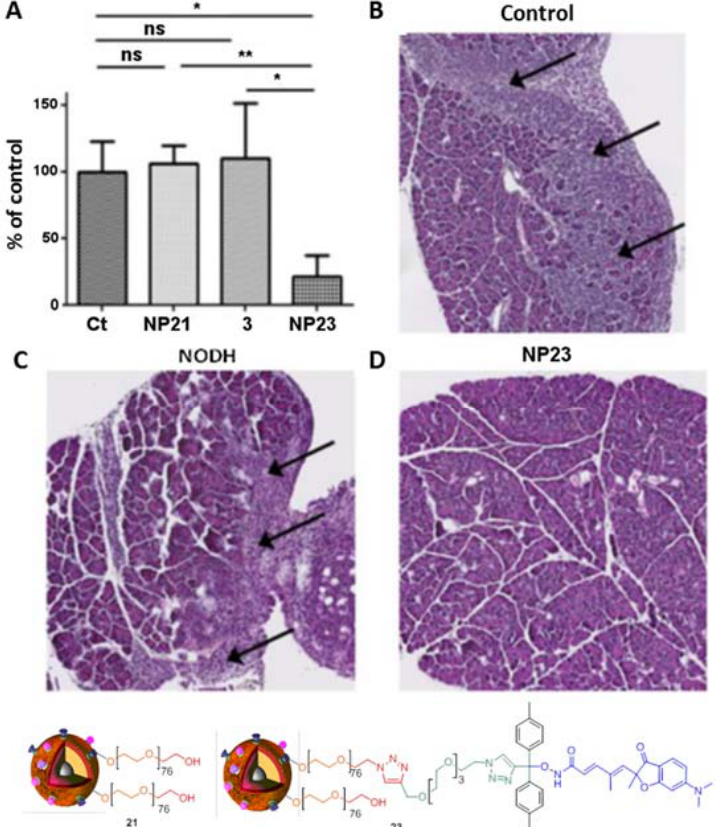
Figure 6. Anti-tumor activity of NPs 23 . Four groups (G1-G4) of C57Bl/6 mice bearing orthotopic AK7 tumor received intraperitoneal injection of decitabine (4 µ g/g) at days 7 and 9, followed by injection IV of NPs 21 (hydroxyl NPs 80 µ g/g, G2), of NODH (0.25 µ g/g, G3), or NPs 23 (0.25 µ g/g compound, 16 µ g/g polymer, G4). G1 group received no treatment. ( A ) Graphic representation of tumor weight at the end of the protocol. ( B – D ) Histological pictures after HES staining of pancreas from control group G1 ( B ), group G3 treated with NODH ( C ), or group G4 treated with NPs 23 ( D ). Arrows indicate infiltration of tumor cells in pancreatic tissue. Ns, none significant. * p < 0.05. ** p < 0.01. The anti-tumor effect obtained in the group treated with NPs 23 was associated with an increase of histone H3 acetylation in cancer cells (brown staining of cell nuclei) (Figure 7A) whereas no change in acetylation level was observed in the other analyzed organs including the liver and kidneys (Figure 7B). Additionally, no toxicity of NPs 23 on blood cells and on key organs (liver, spleen, and kidneys) was observed supporting the safety of the treatment [27].